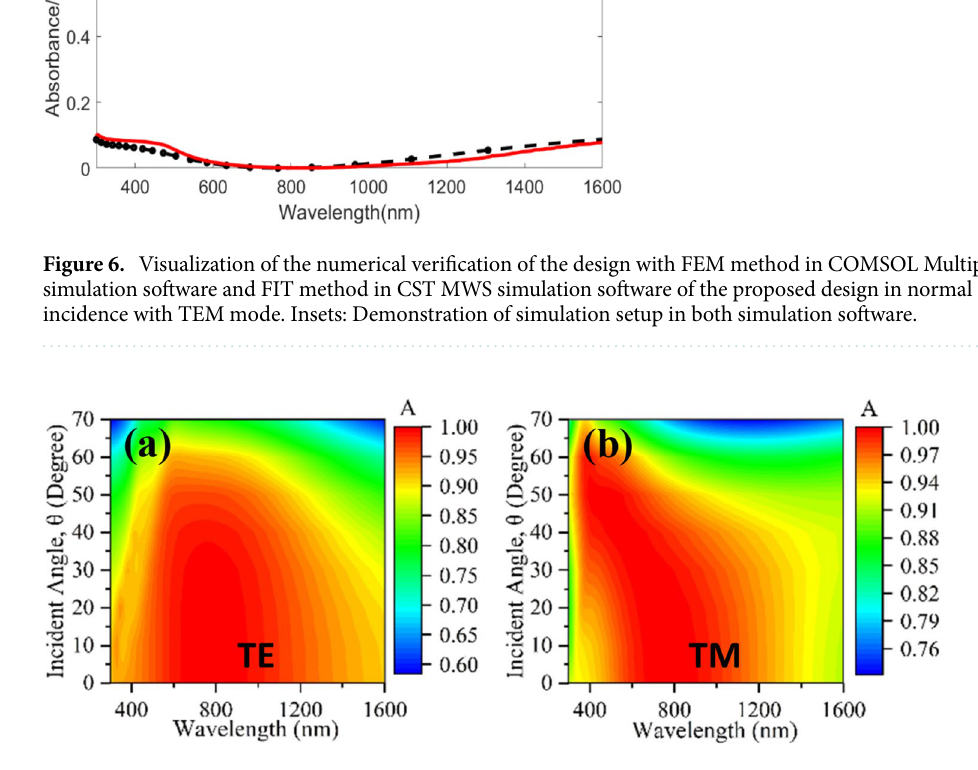
Figure 7. Demonstration of ( a ) incident angle of TE mode from 0° to 70°, and ( b ) incident angle of TM mode from 0° to